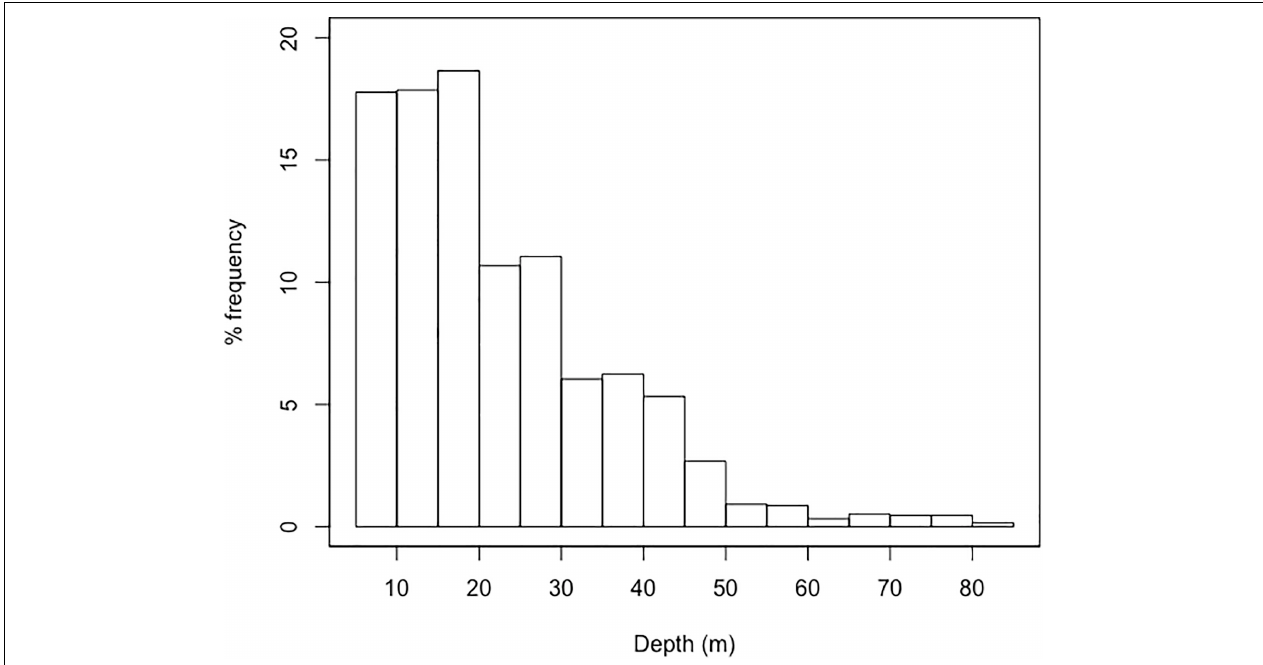
FIGURE 6 | Frequency (%) distribution of feeding depths when exposed to vessel proximity within 400 m while feeding, thus when dives are limited to 4 min or